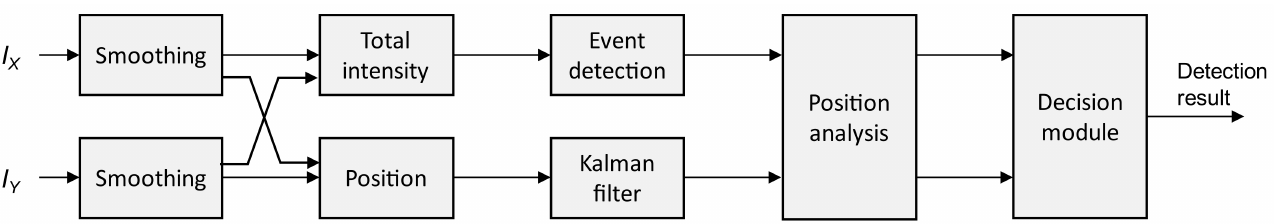
Figure 1. Block diagram of the proposed algorithm.